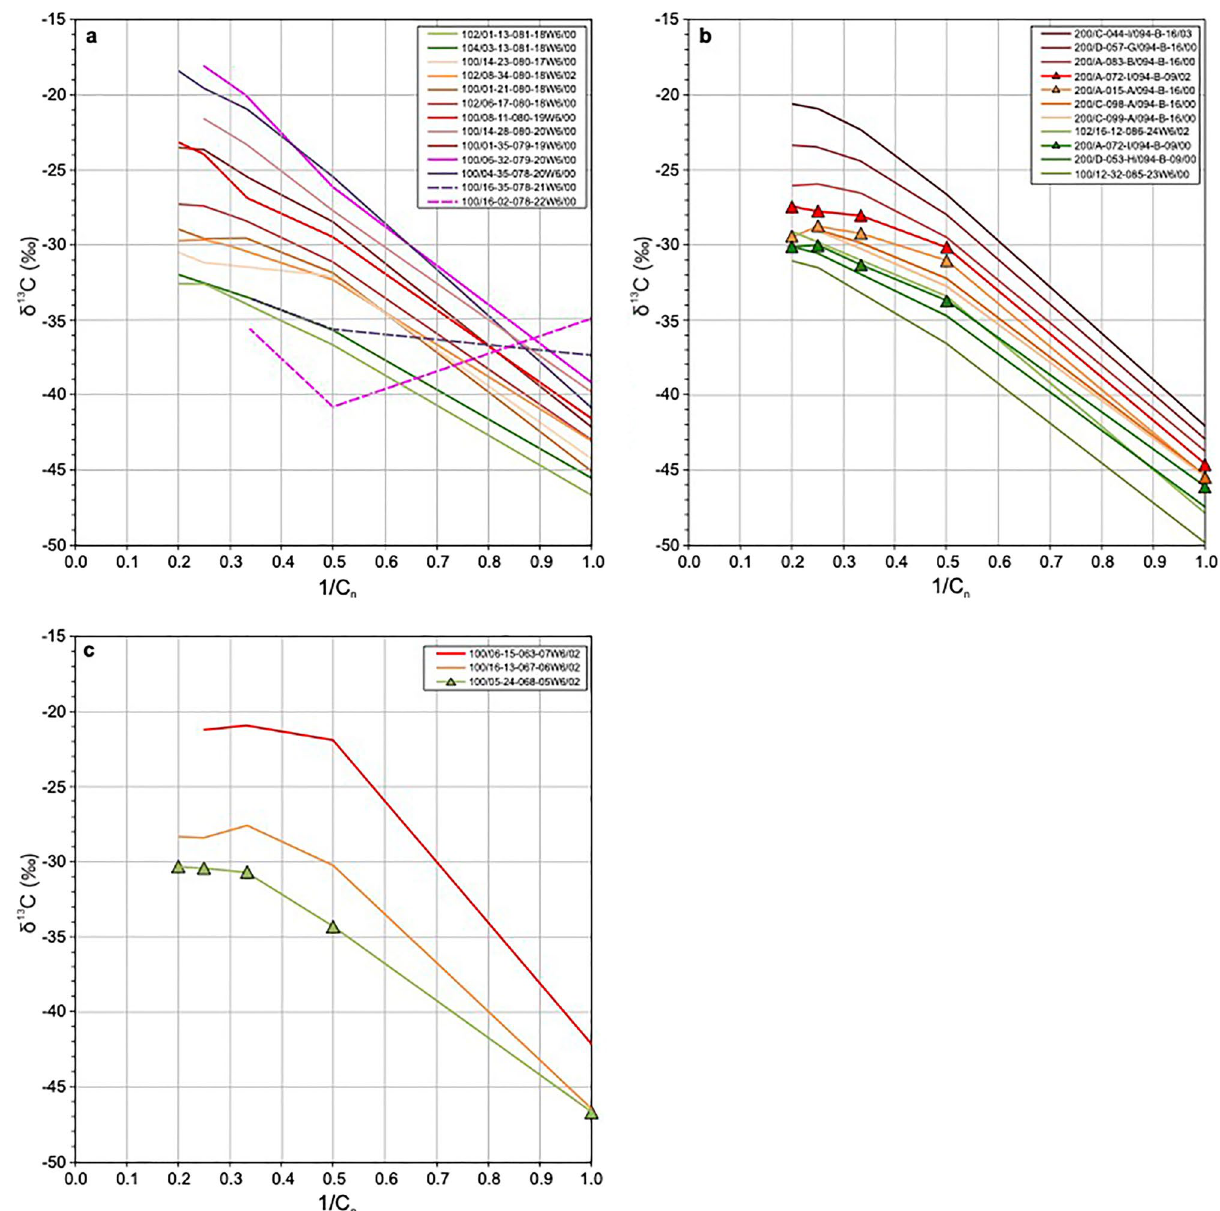
Figure 4. Chung plots 53 of carbon isotope ratio data for Montney produced gas samples. ( a ) Tower- Groundbirch area. ( b ) North Montney area. ( c ) Gold Creek area. Dashed lines in panel ( a ) delineate gas samples from an isotopic rollover/reversal zone 51,52 . All the other gas samples have normal isotopic signatures 51,52 . Triangles in panels ( b , c ) indicate samples with co-produced hydrocarbon liquid data shown in Fig. Carbon isotope ratios of co-produced gas and hydrocarbon liquid. The four wells with gas samples indicated by triangles in Fig. 4b,c were also sampled for carbon isotope ratio analysis of co-produced hydrocar- bon liquids. Supplementary Table S3 lists the carbon isotope ratio data of the produced hydrocarbon liquid sam- ples from these wells: three from the North Montney area and one from the Gold Creek area (Fig. 1a). Figure 5 shows compound-specific isotope analysis (CSIA) data for both co-produced gas (triangles) and hydrocarbon liquid (circles). The data are presented as a Chung plot with reciprocal carbon number vs. carbon isotope ratio in Fig. 5a, and a cross-plot of carbon number vs. carbon isotope ratio in Fig. 5b. The latter figure helps to clearly show carbon isotope ratios at high carbon numbers, which otherwise cluster closely together on a Chung plot at their corresponding low reciprocal carbon numbers. Co-produced gas and hydrocarbon liquid samples have overlapping and closely matched C 4 and C 5 δ 13 C values in each of the three North Montney wells (red, orange and green lines). In combination, the separate gas and hydrocarbon liquid analyses provide a full carbon isotope ratio profile of the produced hydrocarbon fluid of a well from C 1 to high carbon number (maximum of C 33 in well 100/05-24-068-05W6/02, yellow line).